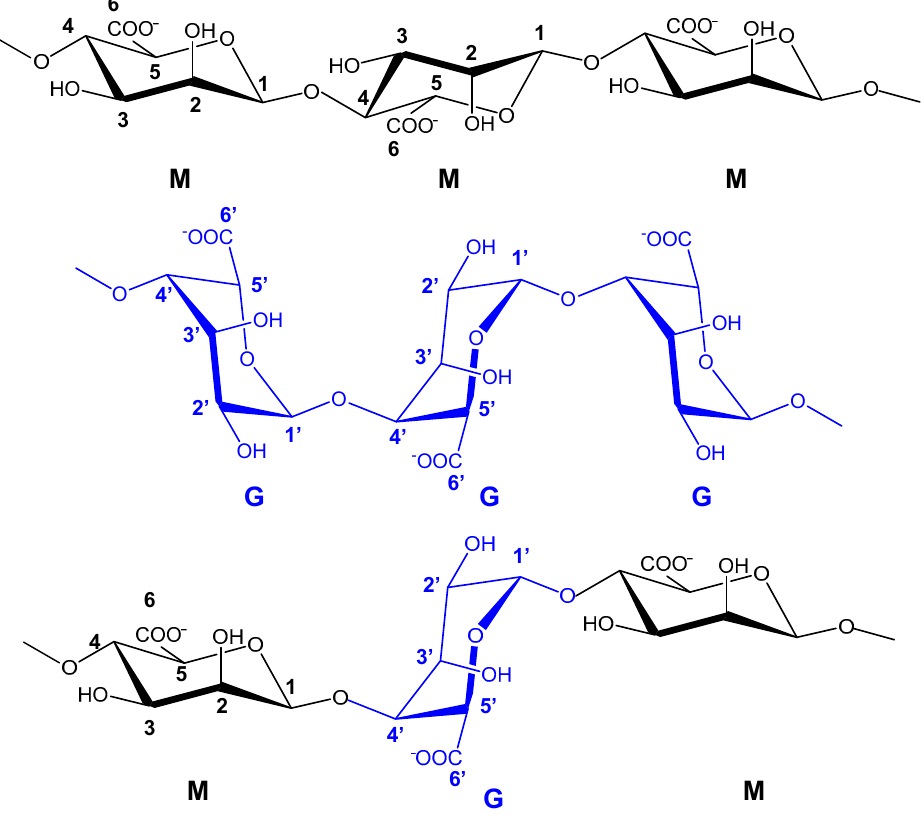
Figure 6. Schematic representation of the M-block, G-block and alternating block in alginate.